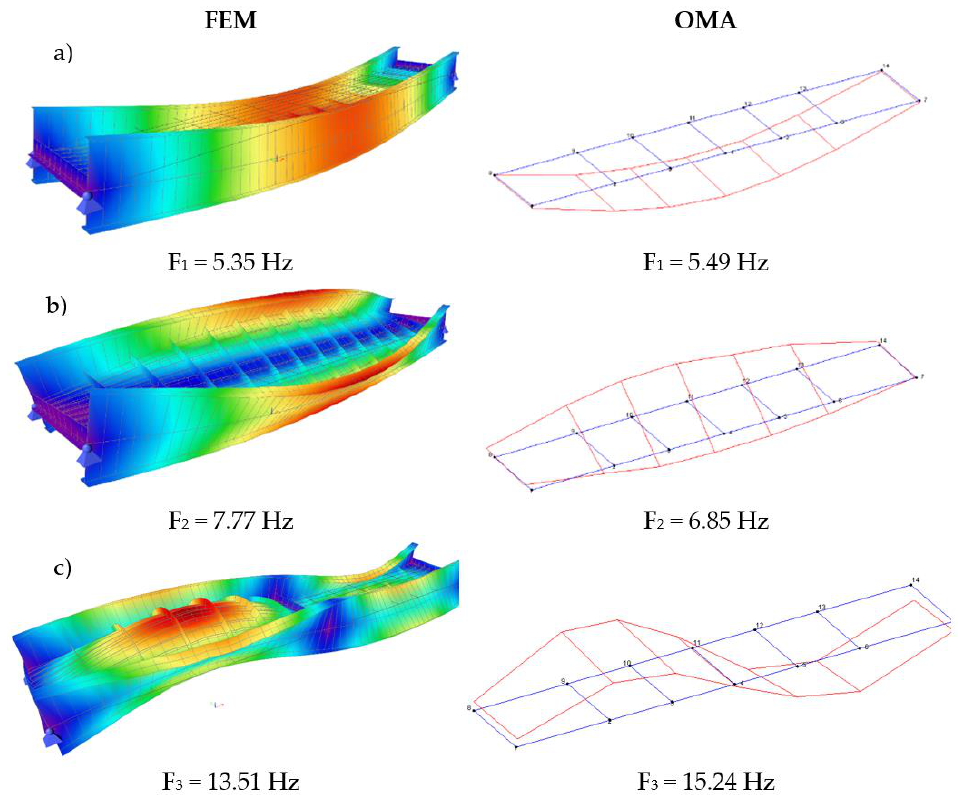
Figure 9. First ( a ), second ( b ), and third ( c ) modal shape and frequencies computed by FEM (left side on figures a – c ) and determined by means of accelerometers during the dynamic load testing of the bridge (right side on figures a – c